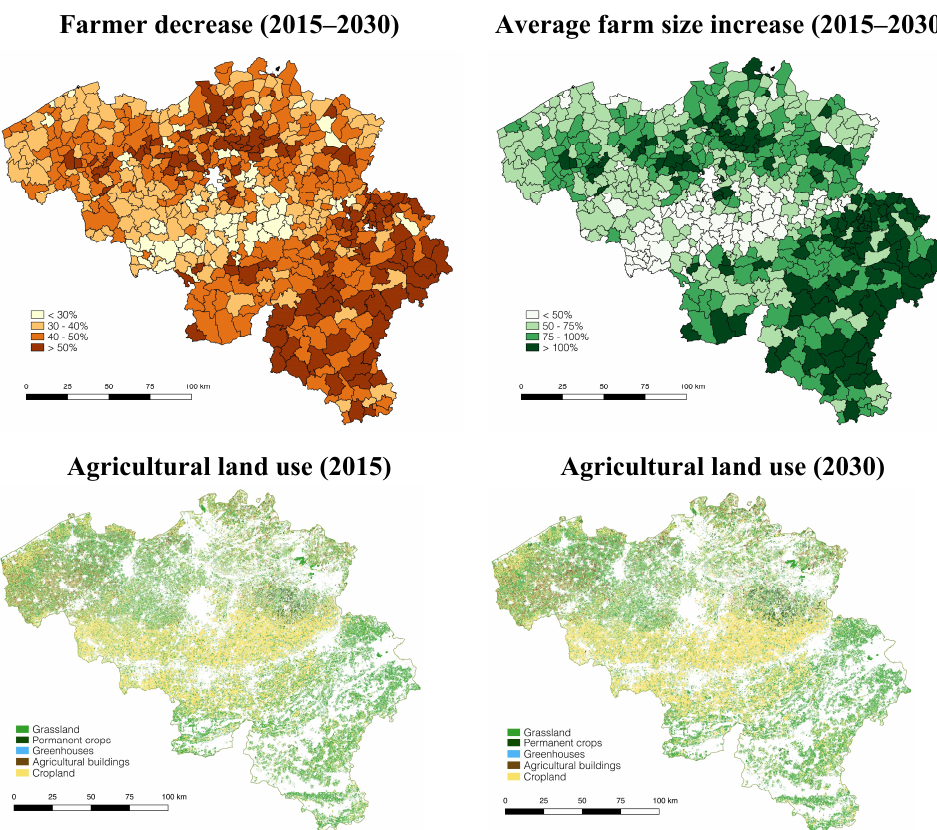
Figure 9. Observed vs. predicted percentage of farmer decrease between 2000 and 2010.